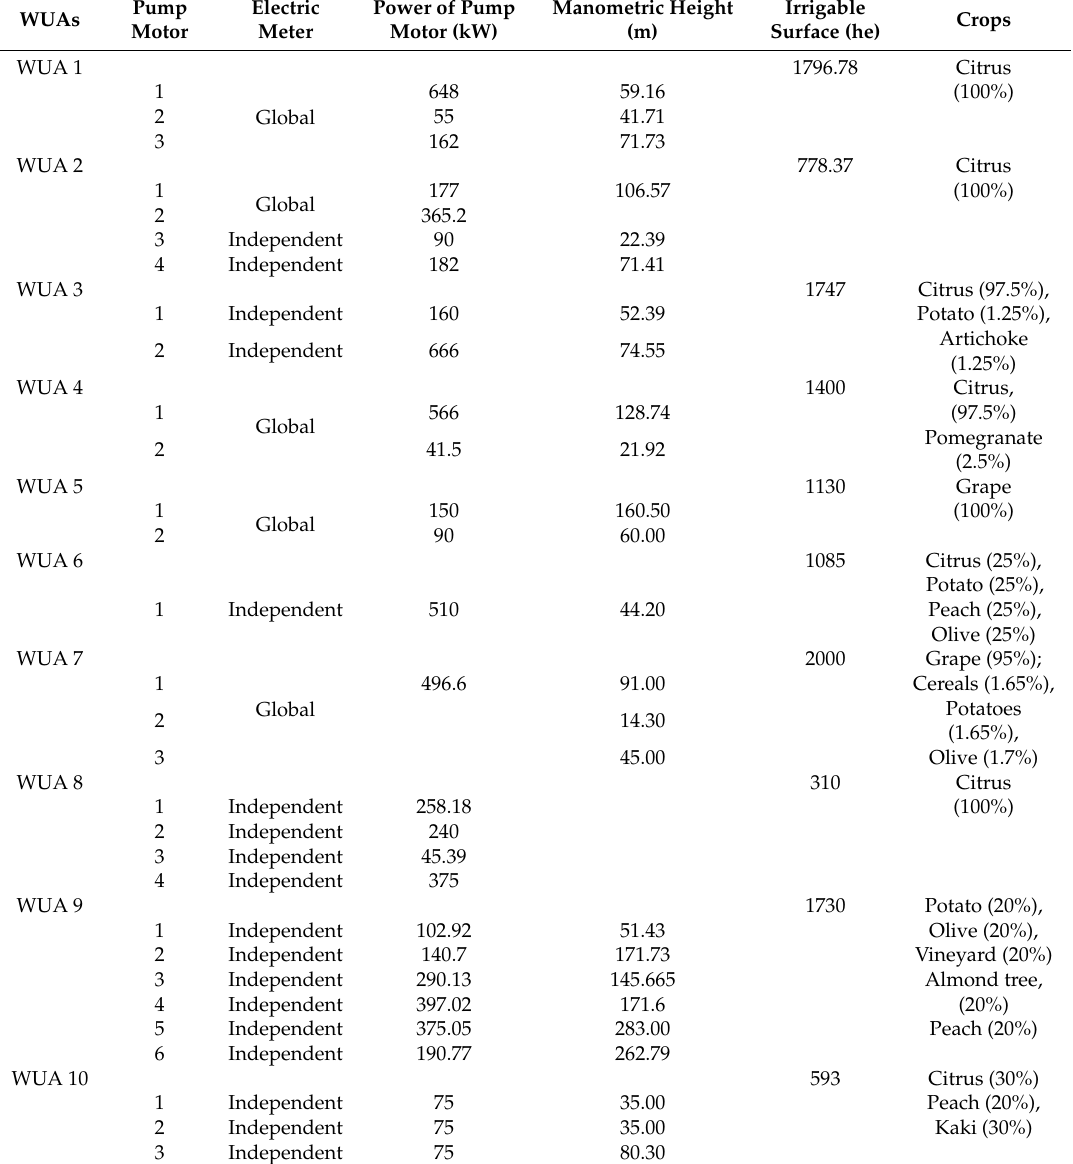
Table 2. Characteristics of the